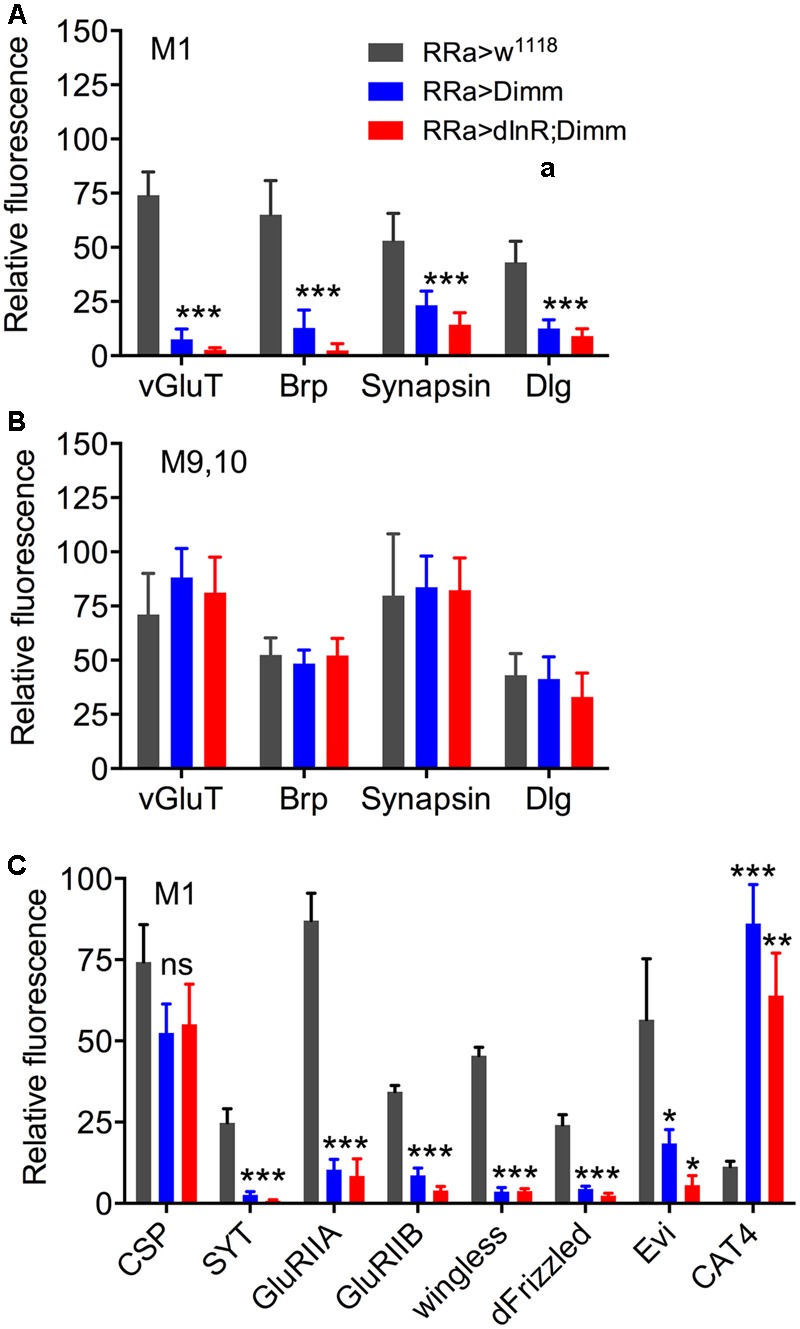
Quantification of Dimm-induced changes in synaptic markers in axon terminations. (A) Relative changes in immunolabeling levels in terminations of aCC neurons (muscle 1; M1) of vGluT, bruchpilot (Brp), synapsin, and disks large (Dlg). Both for ectopic Dimm and Dimm+dInR expression all the markers were significantly reduced. Data are presented as means ± SEM; with 7–9 larvae from three biological replicates (∗p < 0.05, ∗∗p < 0.01, ∗∗∗p < 0.001), as assessed by two way ANOVA test followed by Tukey’s multiple comparisons test. (B) As a control markers in axon terminations on muscle 9/10 (not innervated by aCC neurons) were recorded. No significant changes in maker expression were seen in these terminations. (C) Relative changes in immunolabeling levels in terminations of aCC neurons (muscle 1; M1) of cysteine string protein (CSP), synaptotagmin (SYT), glutamate receptor IIA (GluRIIA) and IIB (GluRIIB), wingless, frizzled, evenless interrupted (Evi) and the transporter CAT4. Dimm and Dimm+dInR expression induces no change in CSP, increases CAT4, and decreases the other markers. Data are presented as means ± SEM; with 8–10 larvae from three biological replicates (ns, not significant), as assessed by two way ANOVA test followed by Tukey’s multiple comparisons test.